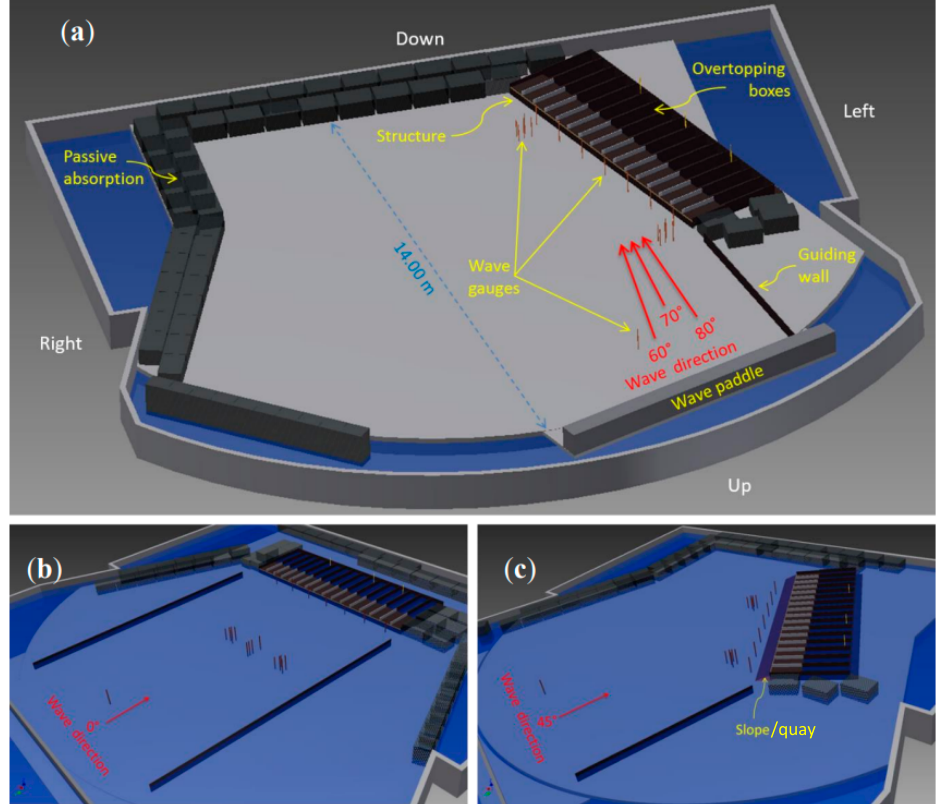
Figure 1. The position of the structure in the wave basin during experiments of Dan et al. [4]: ( a ) wave direction 80°; ( b ) perpendicular wave attack 0°; ( c ) wave direction 45°. The length of the structure is 8 m in the model scale (1/50) (this figure is reproduced from Dan et al. [4]).